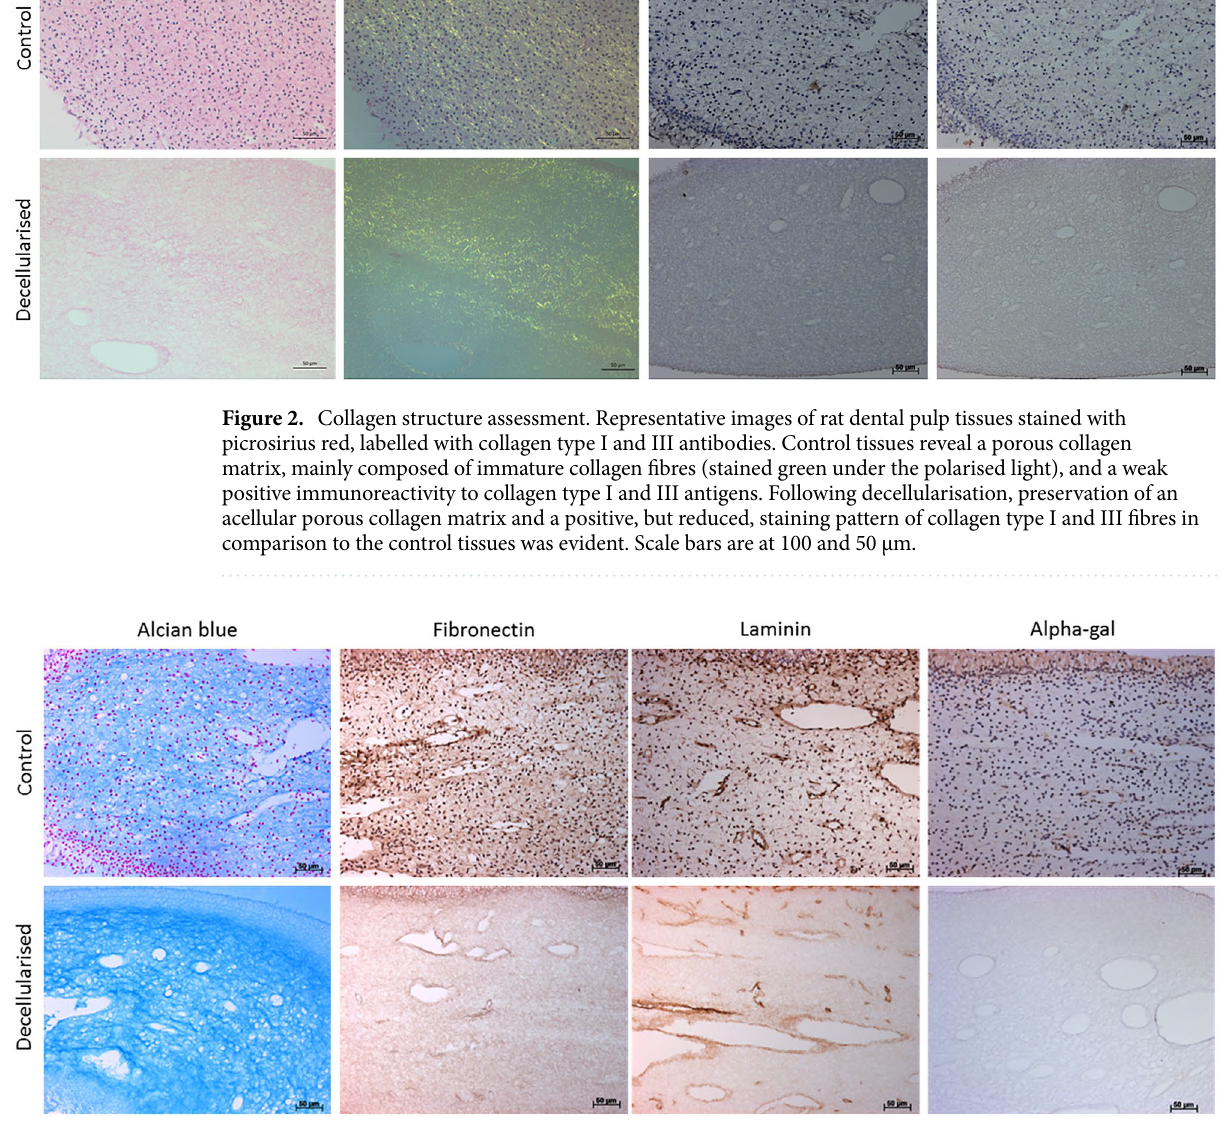
Figure 3. Non-collagenous structures assessment. Representative images of rat dental pulp tissues stained with alcian blue, labelled with fibronectin, laminin and α-gal antibodies. Control tissues reveal a rich glycosaminoglycans rich matrix and a positive immunoreactivity to fibronectin, laminin proteins and α-gal. Following decellularisation, preservation of glycosaminoglycans, fibronectin and laminin proteins with negative α-gal staining was evident. α-gal alpha-1,3 galactose. Scale bars are at 50